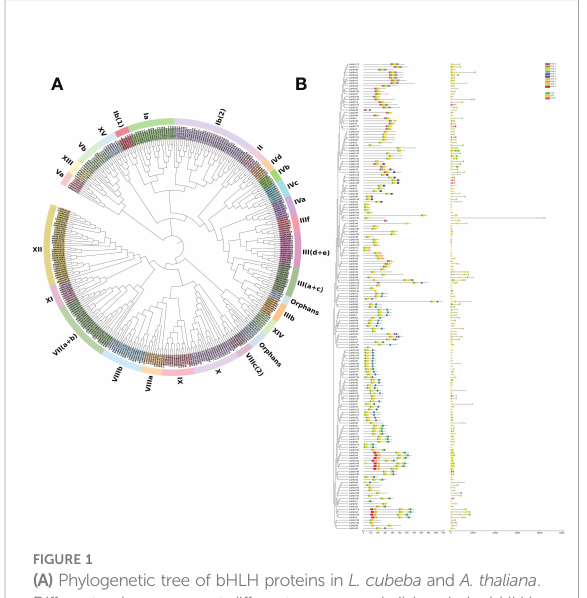
FIGURE 1 (A) Phylogenetic tree of bHLH proteins in L. cubeba and A. thaliana . Different colors represent different groups, and all L. cubeba bHLH proteins are clustered into subclades based on the priority classi fi cation rule of A. thaliana bHLH proteins. (B) Phylogenetic tree, gene structure, and conserved motif analyses of the LcbHLH family. Left: Multiple sequence alignment of bHLH domain sequences of L. cubeba performed using ClustalW. A neighbor-joining tree was reconstructed using MEGA X with 1,000 bootstrap replicates. Middle: Conserved motifs. MEME analysis revealed conserved motifs of LcbHLH proteins. Colored boxes on the right denote 10 motifs. Right: Gene structure. Yellow boxes, black lines, and green boxes represent exons, introns, and UTRs (untranslated regions),